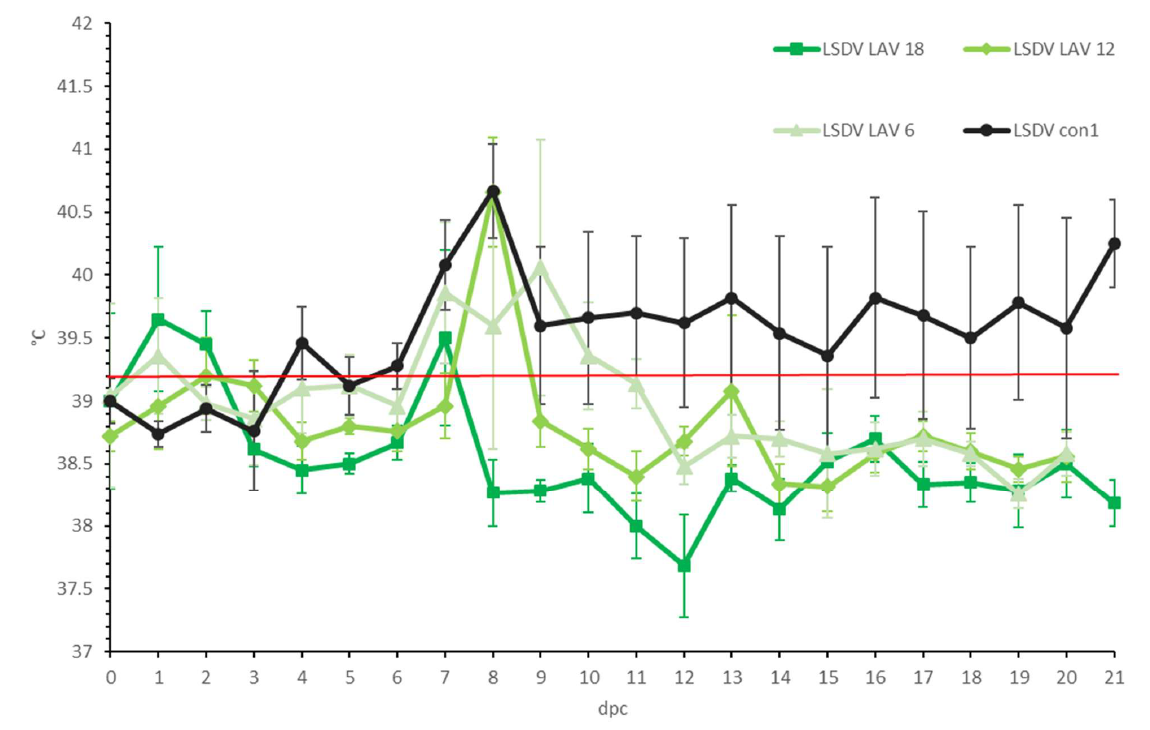
Figure 2. Averaged body temperatures of the LSDV LAV groups after challenge. For comparative purposes: the average of the control group LSDV con1 was added. Solid line: fever cut-off for consecutive days; standard deviation is shown as error bars.